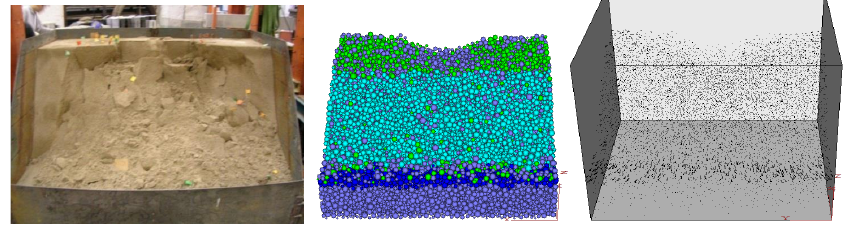
Figure 14 Front view of final failure from laboratory test and DEM modeling Figure 14. Front view of final failure from the laboratory test and DEM modeling.